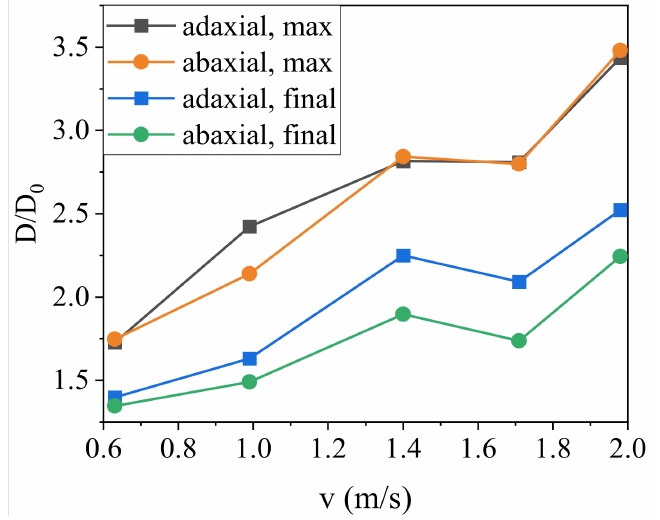
Figure 5. Maximum spreading factor and final spreading